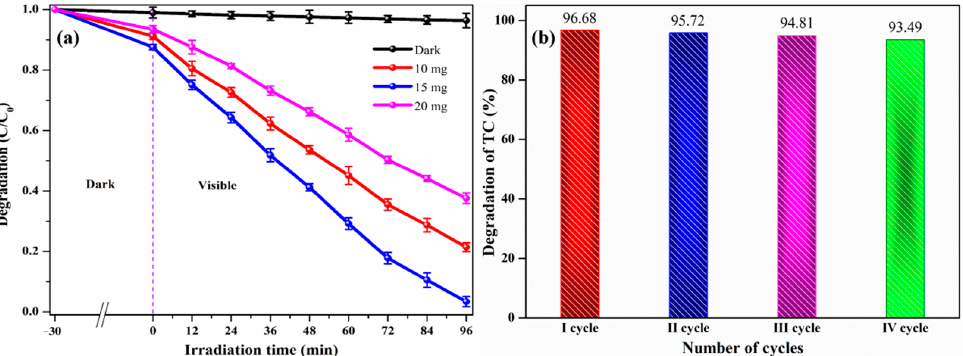
Figure 10. ( a ) Catalyst loading and ( b ) stability test over the IVNF-5.0 nanocomposite for the degradation of TC.